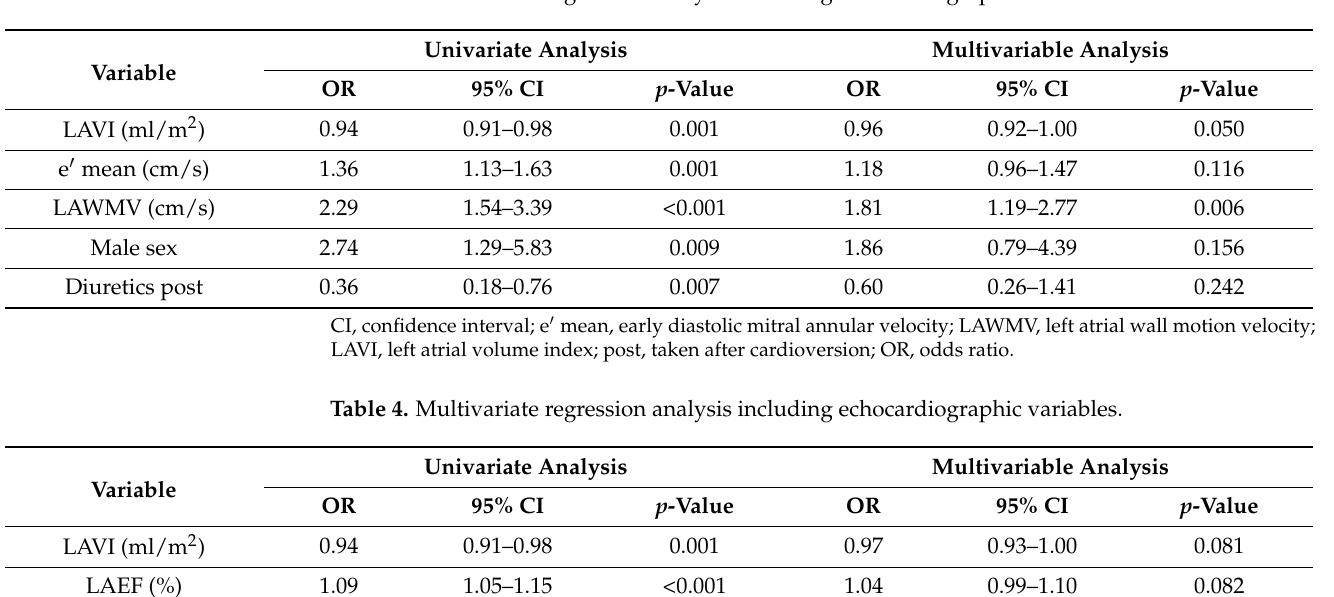
Table 3. Multivariate regression analysis including echocardiographic and clinical variables.